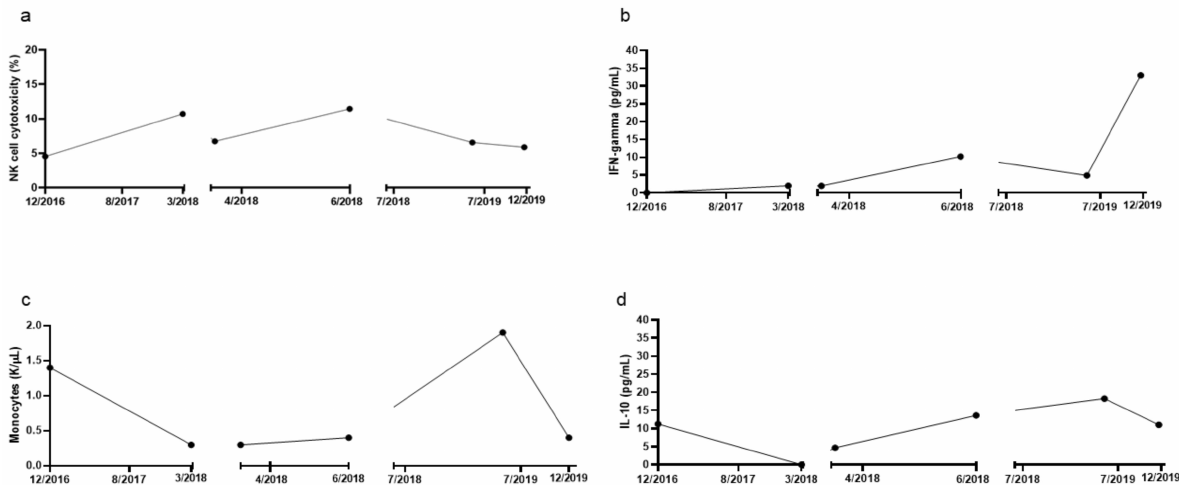
Figure 2. Changes in immune cell function and cytokine secretion in response to r-IL-2 immunotherapy. ( a ) Percent of NK cell cytotoxicity as measured in a whole blood chromium release assay. ( b ) IFN-gamma levels (ELISA) in peripheral blood. ( c ) Absolute monocyte cell count monitored by complete blood count. ( d ) IL-10 levels (ELISA) in peripheral